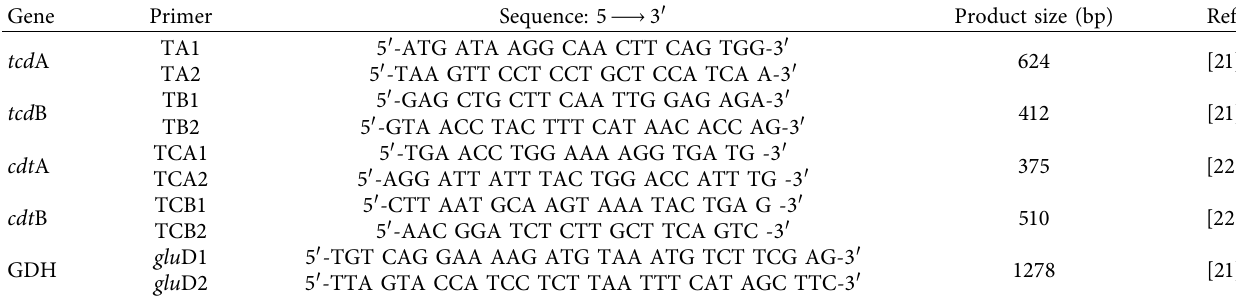
Table 1: Primer sequences used for amplification of tcd A, tcd B, cdt A, cdt B, and glu D genes. Gene